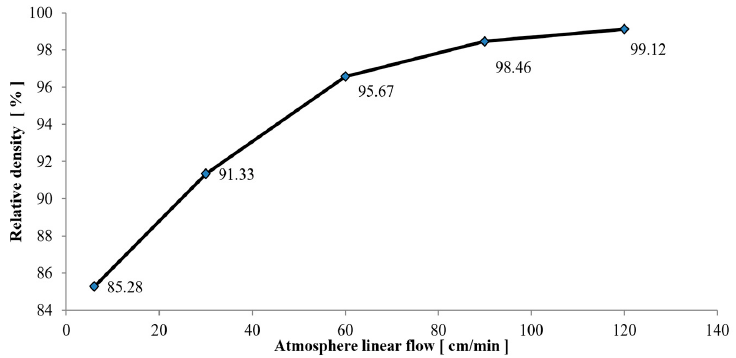
Figure 4. Relative density (%) of sintered Alumix 431D vs atmosphere linear flow (cm/min).